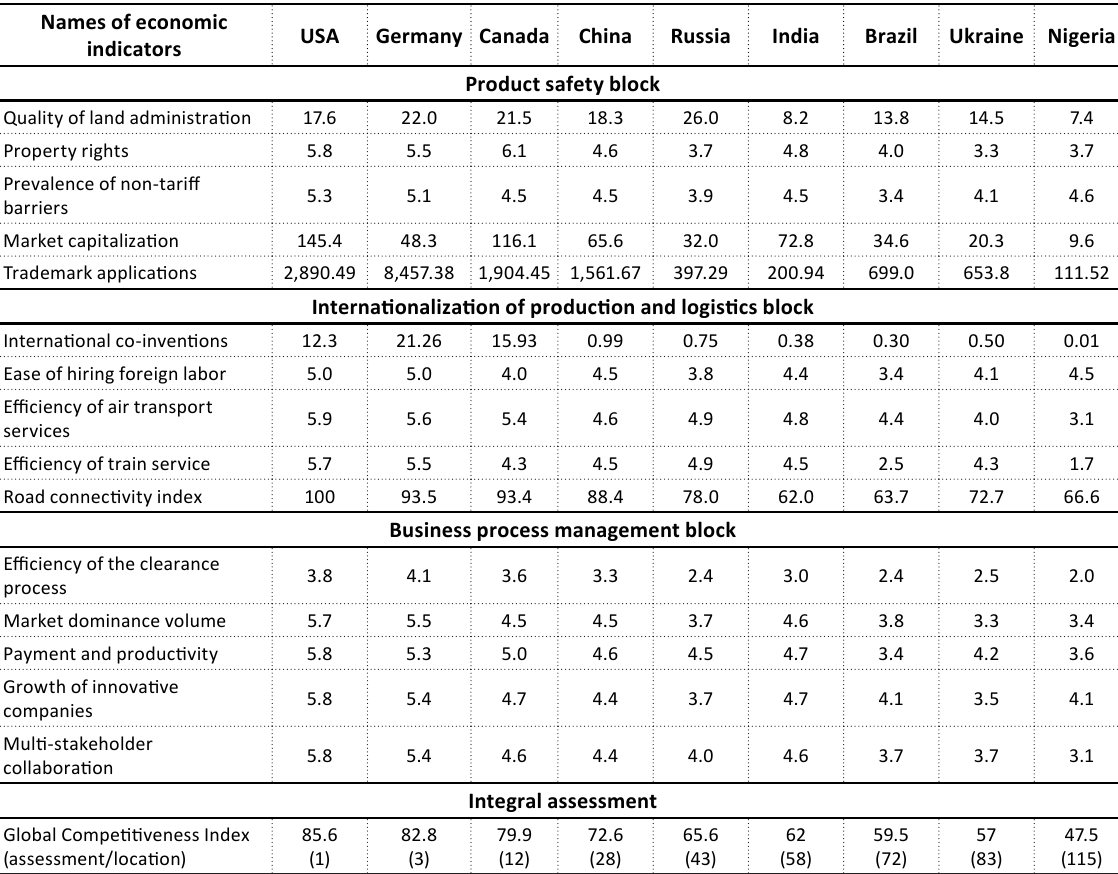
Table 1. Comparative analysis of the logistic management of the main countries of agricultural production of the worl in 2018, c.u./location